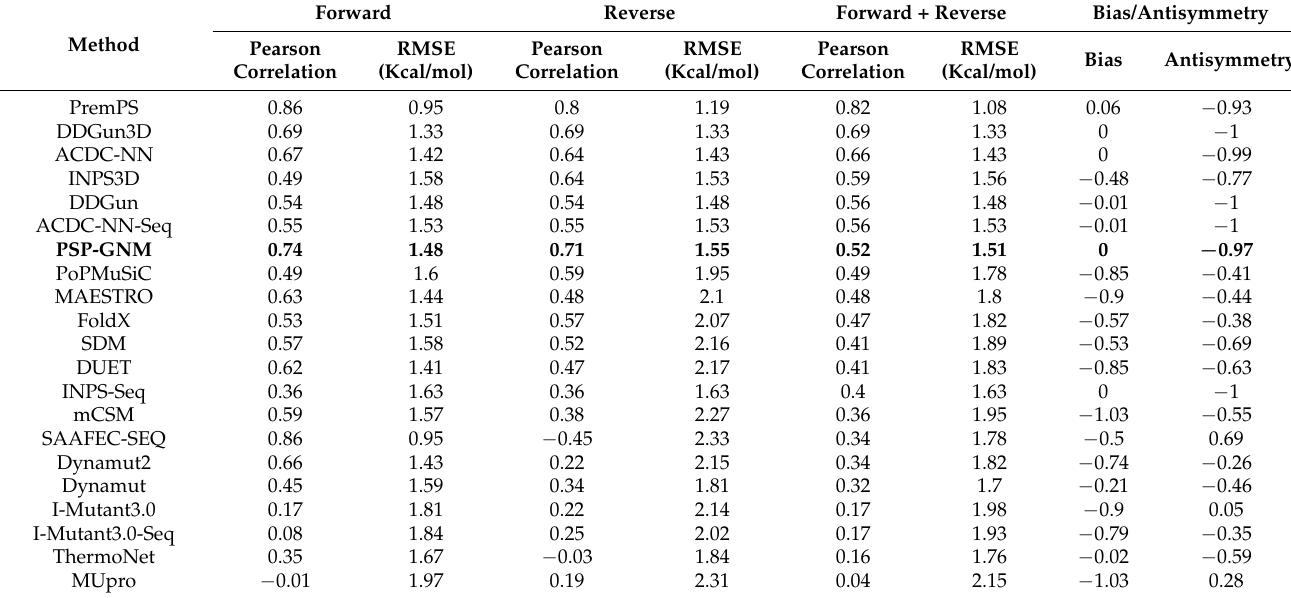
Table 9. Performance comparisons on the Ssym+ dataset for a subset of 37 mutations with experimen- tal temperatures ranging from 20 ◦ C to 30 ◦ C and pH ranging from 6.8 to 7.2. The 37 mutations had at least one contact broken, both in the wildtype and mutant forms, for the residue at the mutation position when simulating unfolding with PSP-GNM. The table is sorted by Pearson correlation in the Forward + Reverse category. The performance for PSP-GNM is shown in bold.